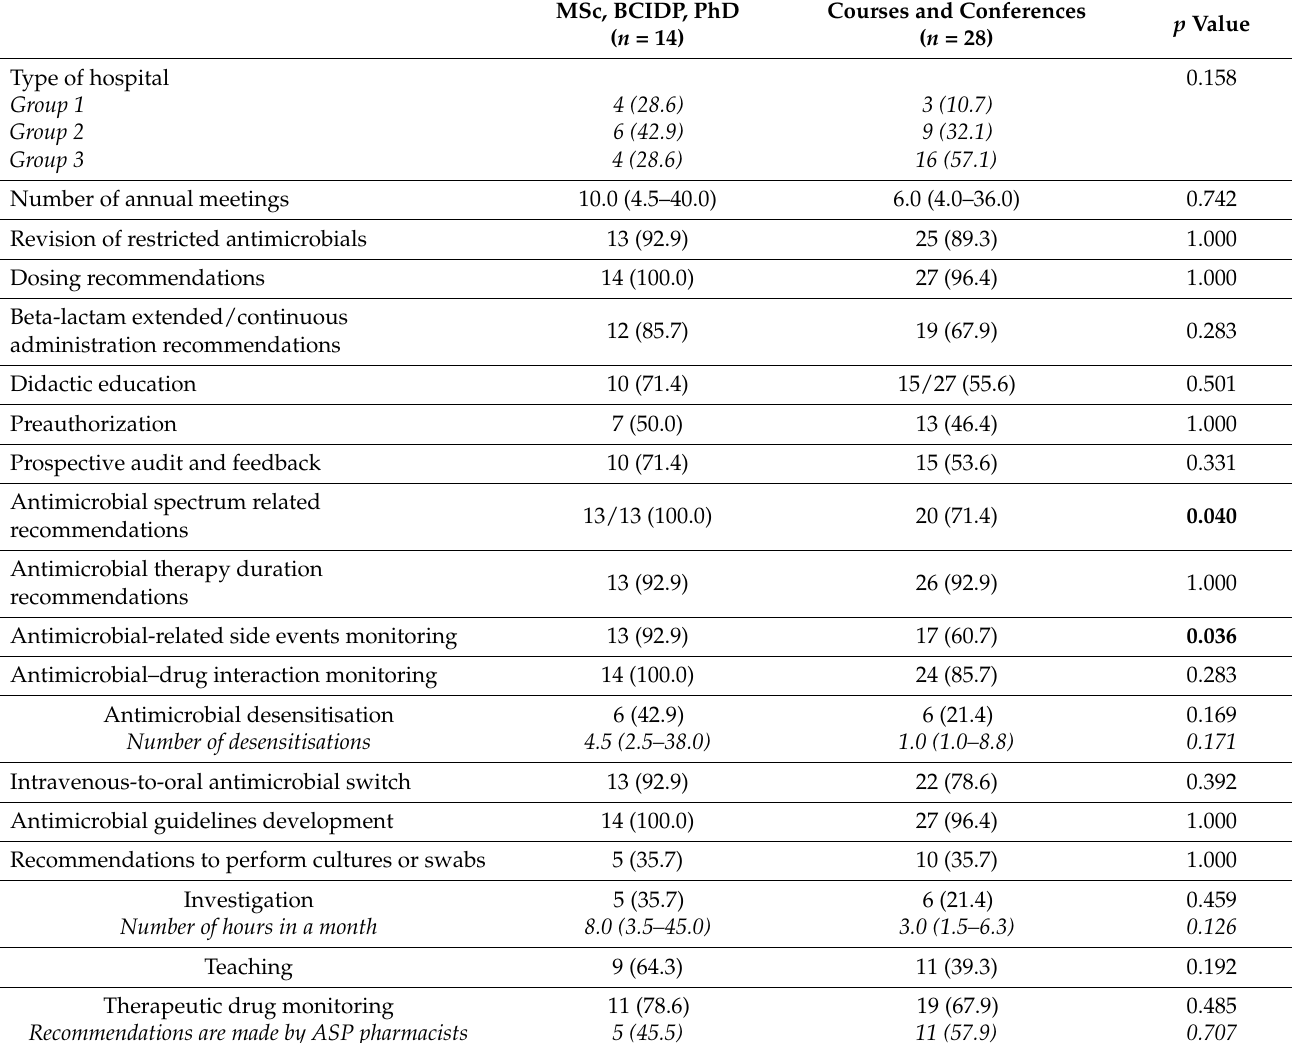
Table 4. Type of performed antimicrobial stewardship activity depending on infectious disease